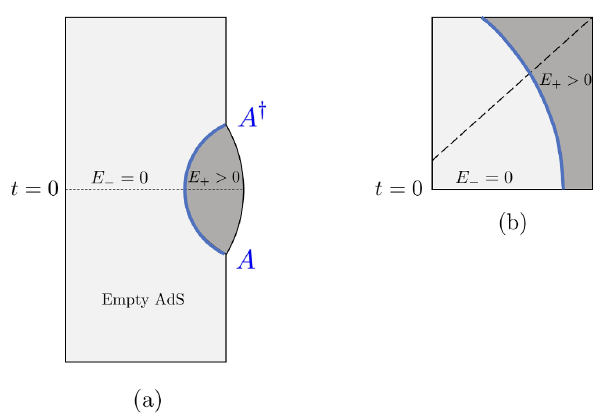
Figure 3 . (a) Euclidean picture. The shell can be viewed as computing a two point function. We can view the cut along the dotted line as the state created by the operator. (b) Picture we obtain after we evolve the state from (a) into Lorentzian time. The dashed line is the